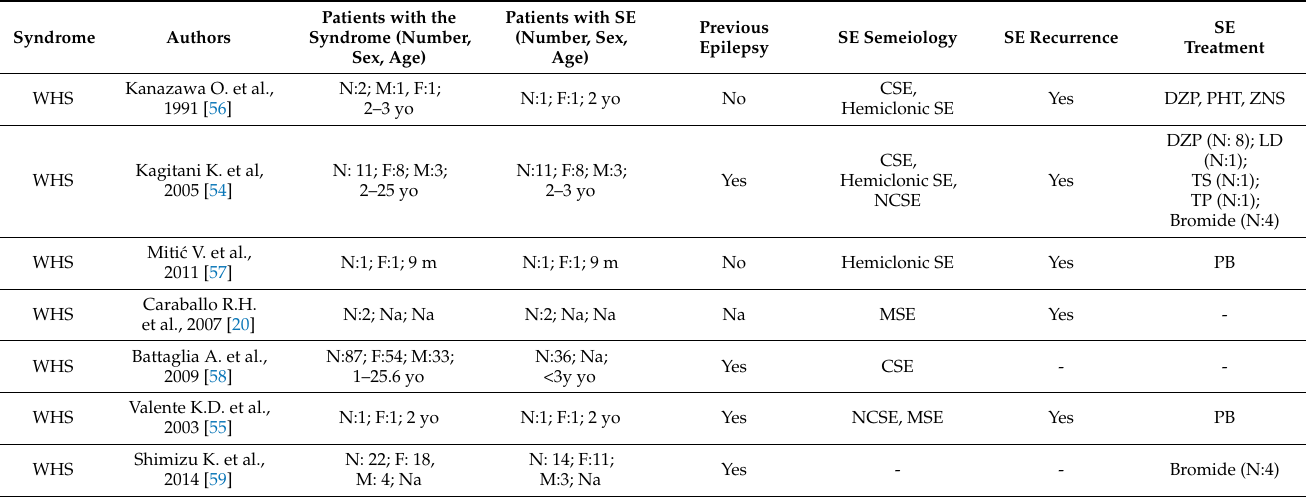
Table 6. Status Epilepticus in other Chromosomal Disorders Associated with